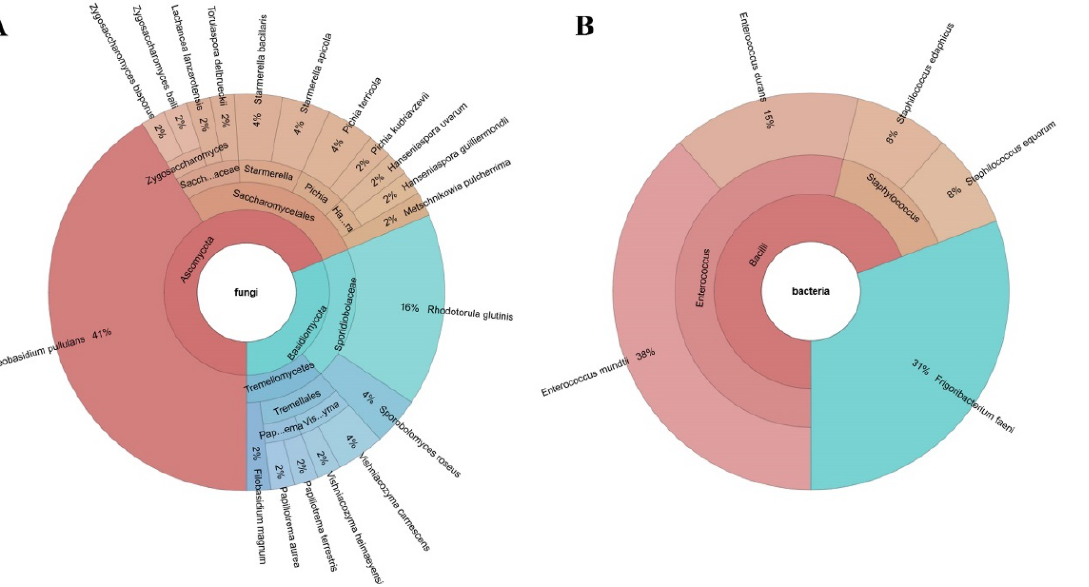
Figure 1. Relative abundances of epiphytic fungal ( A ) and bacterial ( B ) species identified on the fruits of Bisucciu apricot cultivar.